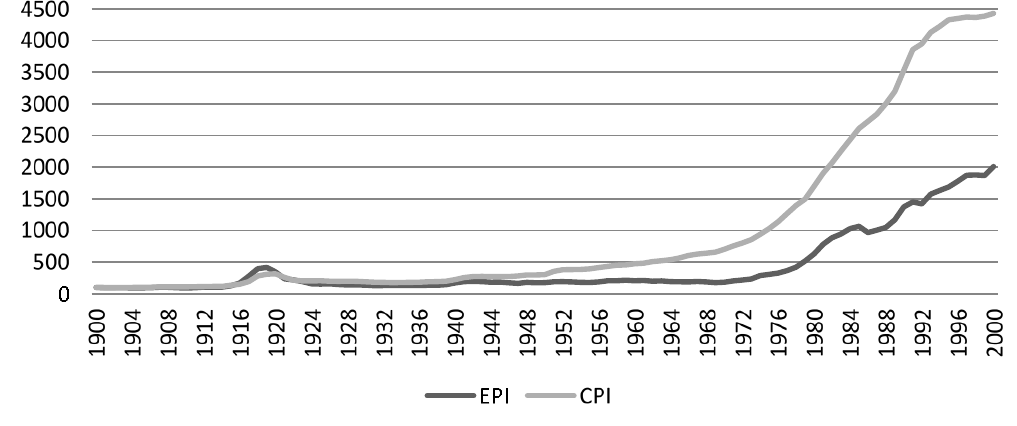
Figure 8. Development of CPI and EPI in Sweden between 1900 and 2009 (1900 =